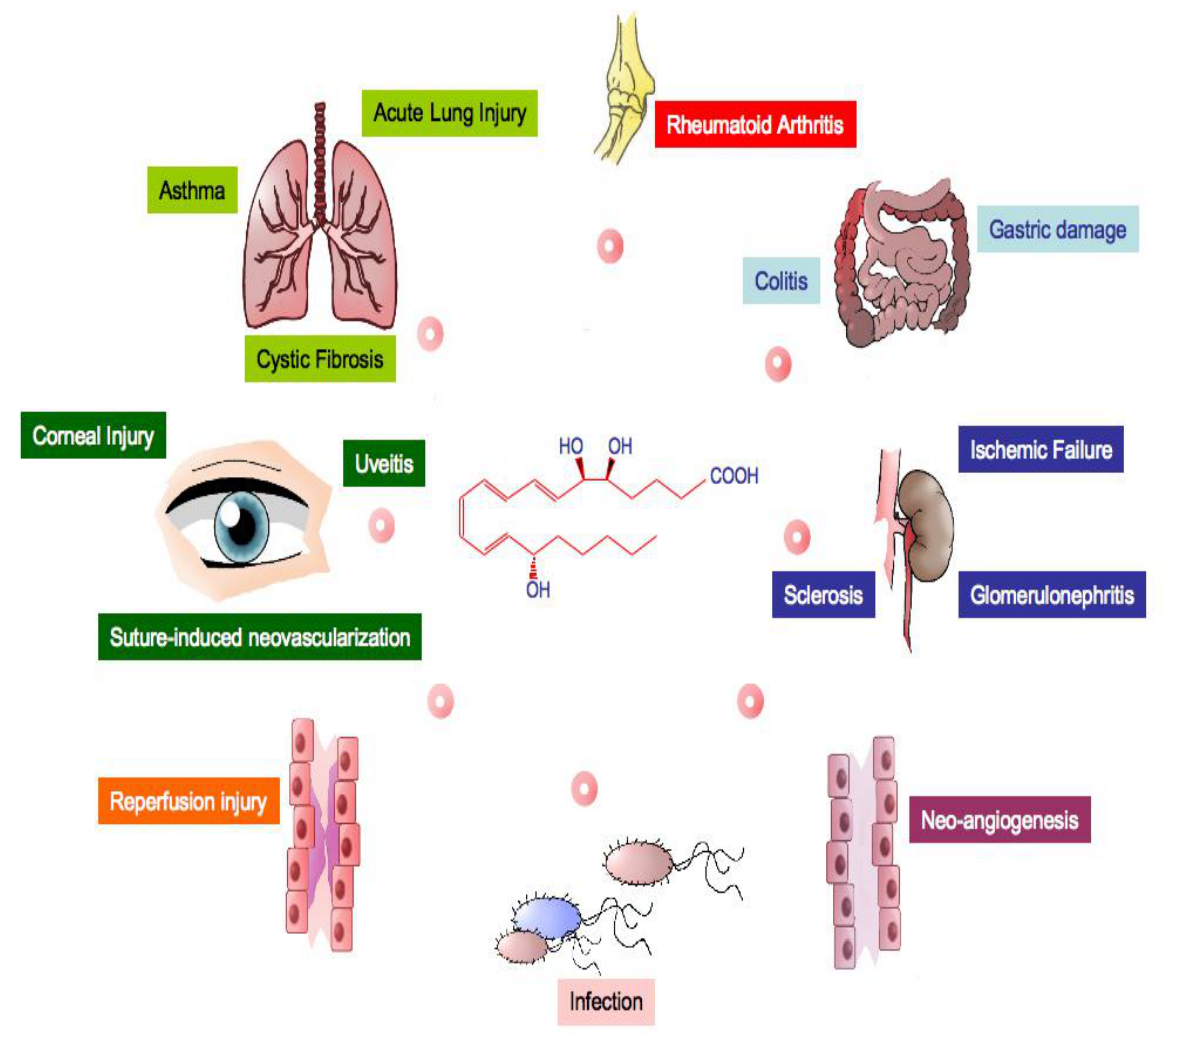
FIGURE 5. Clinical settings where administration of lipoxin A 4 or ATLa could be